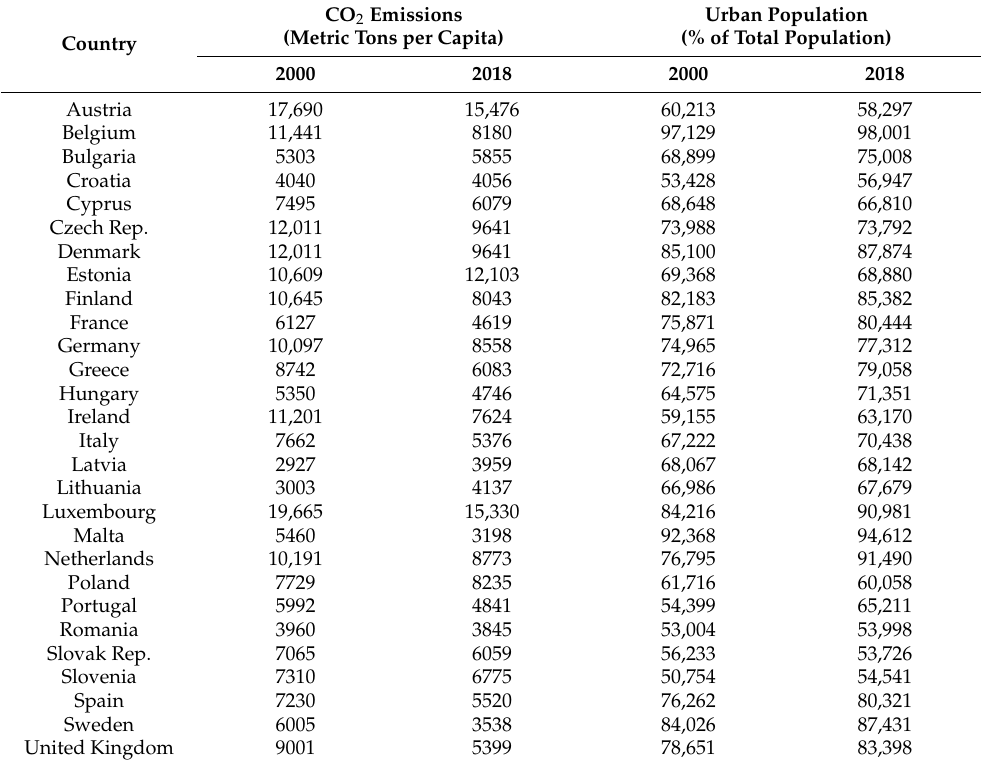
Table A1. CO 2 emissions per capita and urban population in the European Union countries.